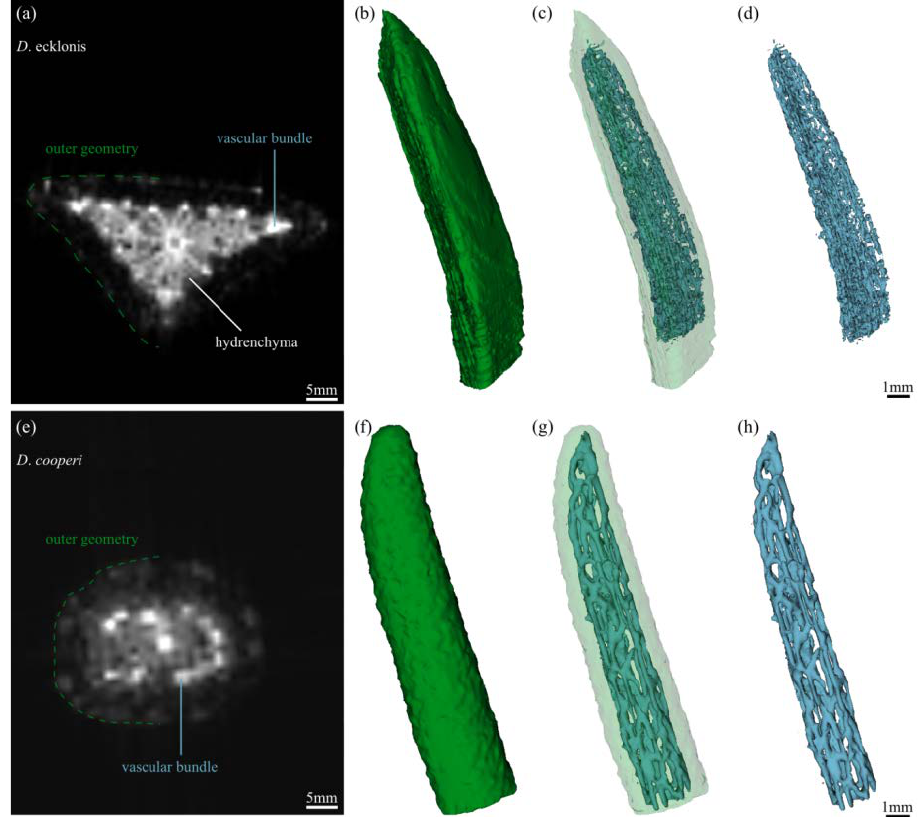
Figure 5. Magnetic resonance imaging of the leaf tips of D. ecklonis ( a – d ) and D . cooperi ( e – h ). ( a ) 2D tomogram (cross-section) of a D . ecklonis leaf. The contrasting agent (MnCl) does not provide su ffi cient contrast between large-celled hydrenchyma tissue and vascular bundles. ( b – d ) Quasi 3D data representation of the outer leaf geometry ( b and c ) and inner 3D vascular system ( d ) of the leaf of D . ecklonis . The low tissue contrast between the hydrenchyma and vascular bundles results in the re- duced quality of the segmentation of the complex vascular network of the leaf in comparison with